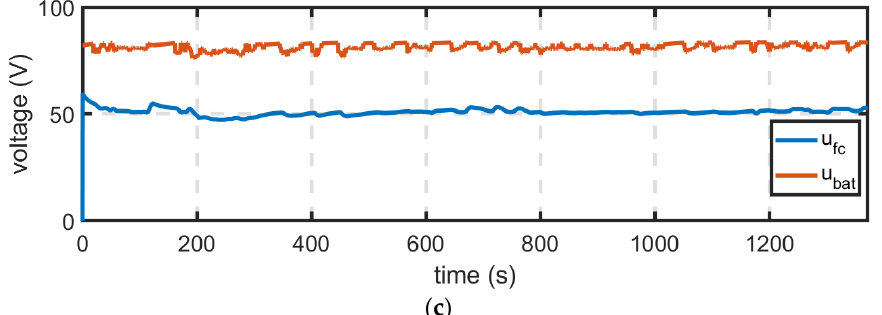
Figure 10. Vehicle simulation results for FTP-72 cycle under ECMS: ( a ) Profile on vehicle’s reference and actual velocity; ( b ) power variation of bus, fuel cell, and battery with time; ( c ) voltage variation of fuel cell and battery.